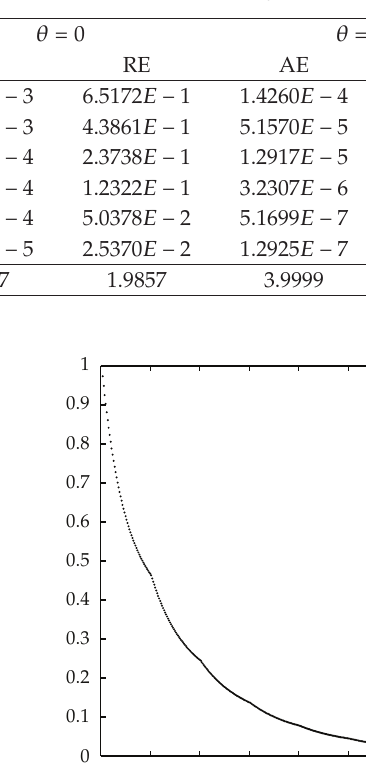
Table 2: One-leg θ -methods for problem (cid:4) 5.1 (cid:5) .